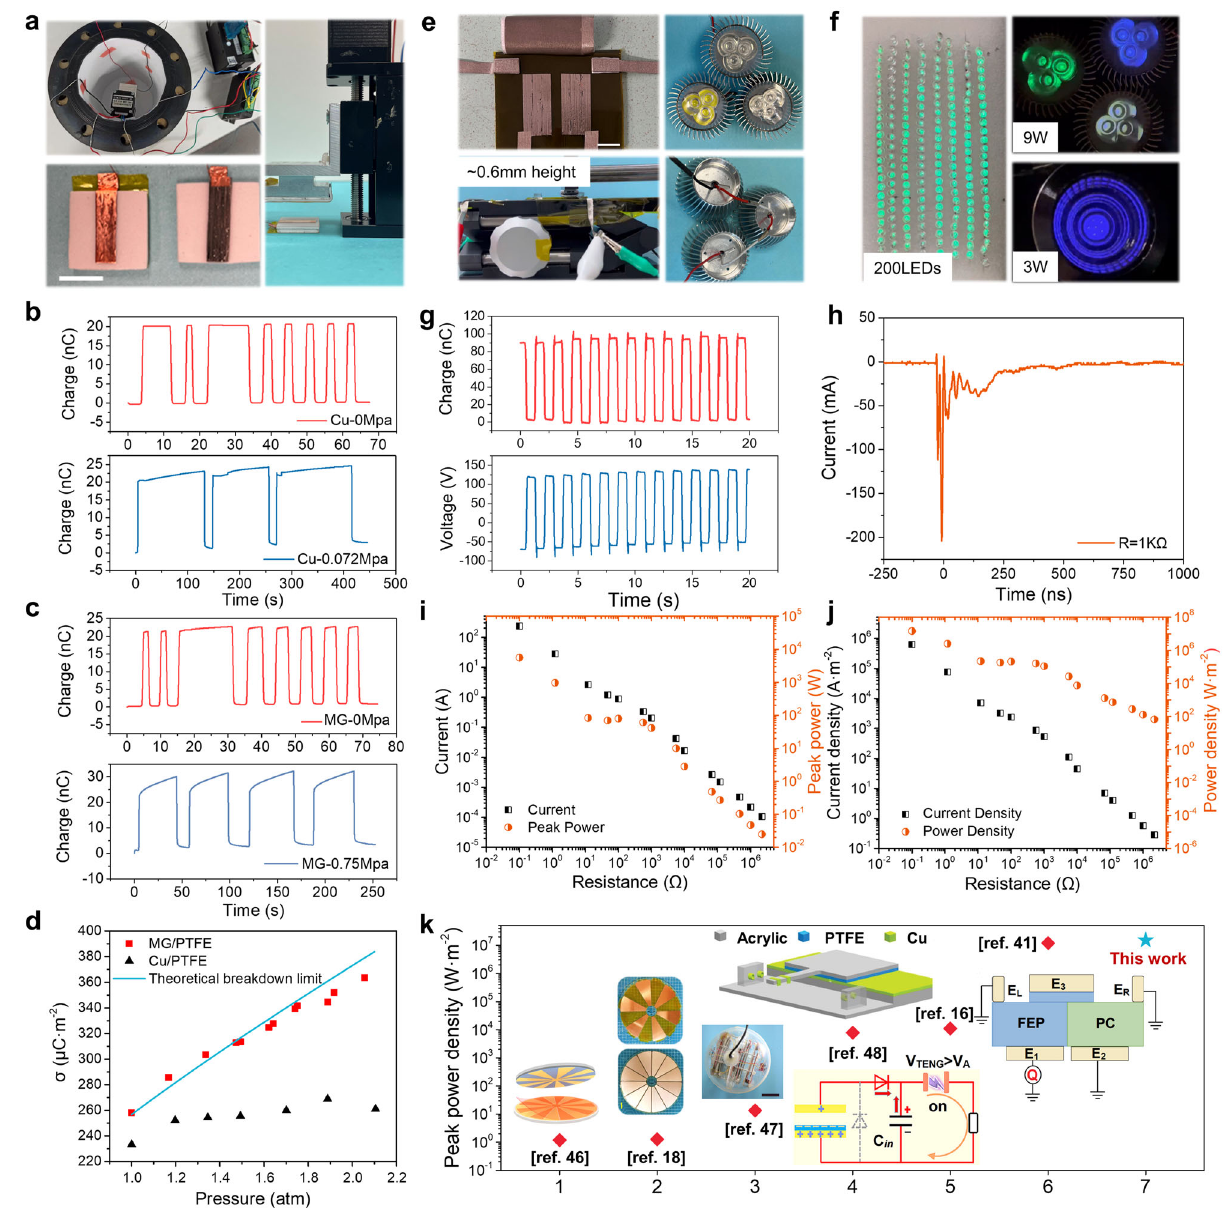
Fig. 5 | Demonstration of the high-performance MG-based TENG. a Photograph of experimental setup of the TENG with high gas pressure. Charge output at a different gas pressure of b Cu/PTFE pair and c MG/PTFE pair. d Summary of the surfacechargedensityofdifferentmaterialpairsatdifferentgaspressure,withthe theoretical line compared. e Setup of the MG-based T-TENG. f Photograph for powered LEDs. g Q SC (top) and V OC (bottom) of MG-based T-TENG. h Current output of the device at resistance of 1k Ω . i The peak current and peak power, j the peak current density and peak power density depending on the load